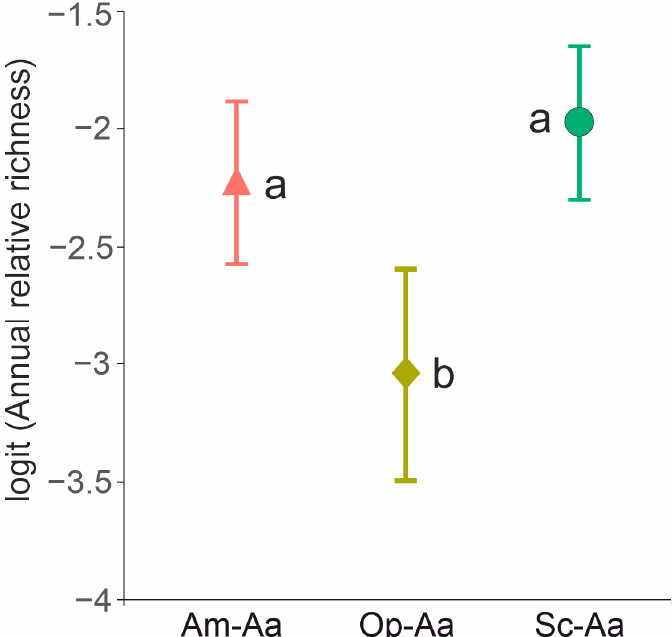
Figure 8. Spatially conditioned least-square means of (logit-transformed) annual relative richness, along with their 95% confidence intervals, in the three Artemisia alba -(co)dominated communities distinguished in the Carpathian and Pontic regions. Different and same letters refer to significant and respectively, non-significant differences. Abbreviations as in Figure 2.